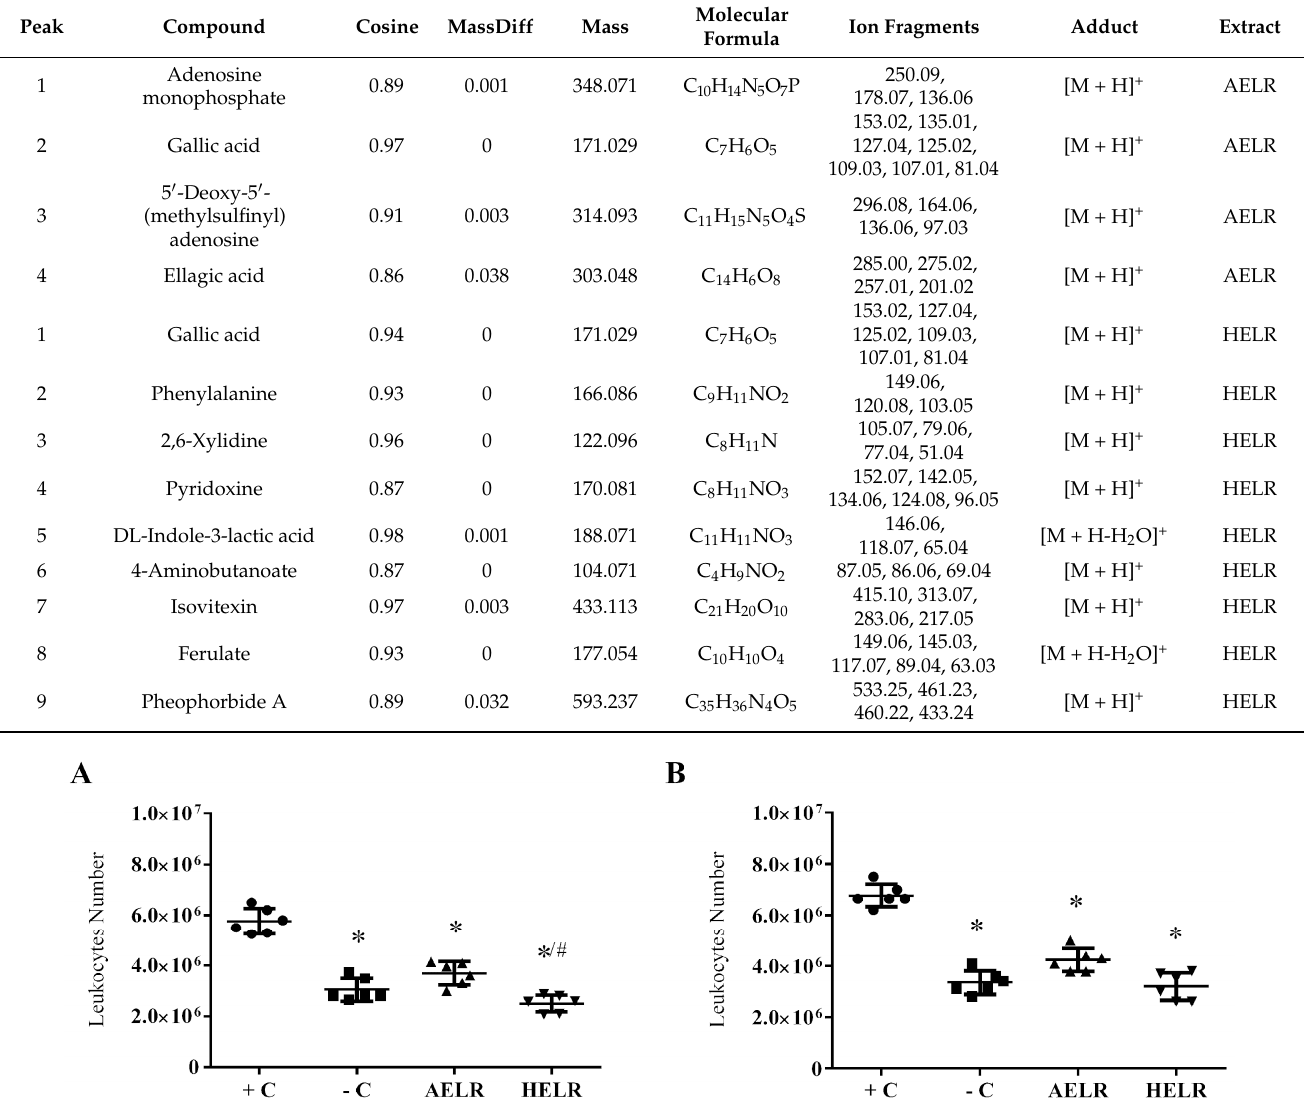
Figure 3. Total leukocyte count in ( A ) LPS-induced peritonitis model and ( B ) differential leukocyte count in an LPS-induced peritonitis model. L. rigida aqueous leaf extract (AELR); L. rigida hydroethanolic leaf extract (HELR), − C (negative control: animals not induced with LPS) and + C (positive control: animals induced with LPS and treated with PBS). Mice were injected in- traperitoneally with 100 µ L of LPS 1 h before the intravenous injection of PBS, AELR, and HELR (25 mg/kg/animal). After 4 h, the peritoneal lavage was evaluated for the total number of cells and compared with the LPS-stimulated positive group; * p < 0.05; # p < 0.05 between the extracts. n =